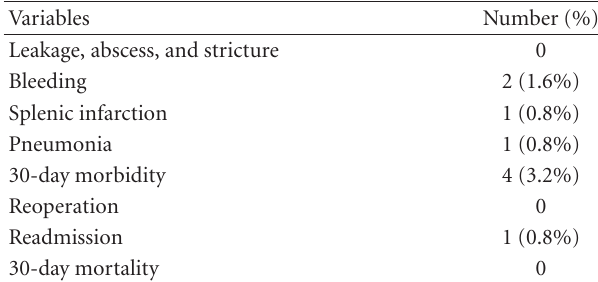
Table 2: Postoperative